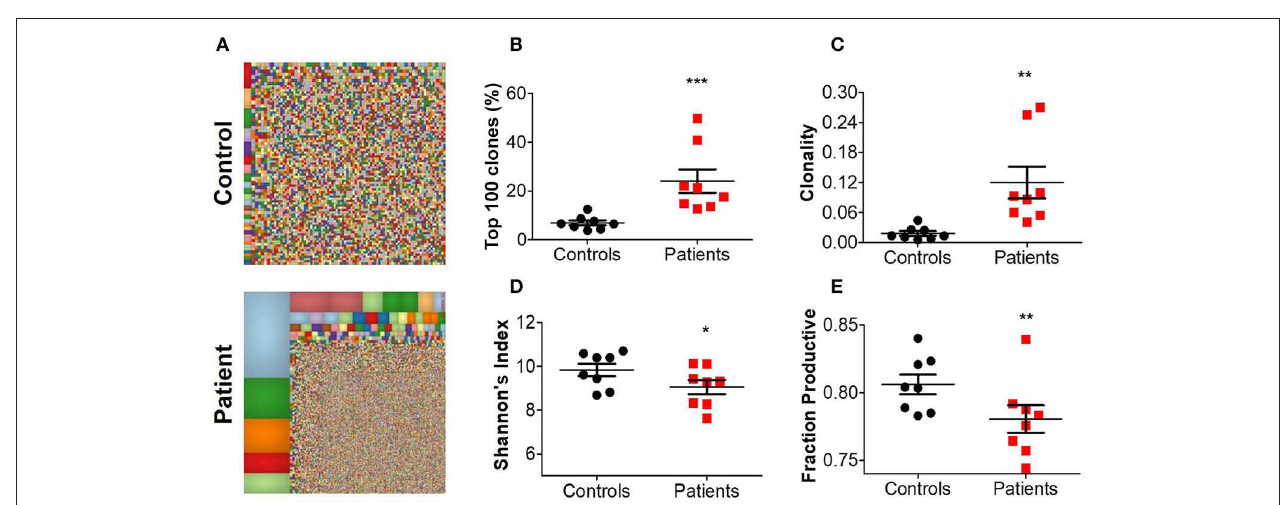
FIGURE 2 | Aberrant TCR repertoire features in blood from patients with IL10 signaling defects. (A) Representative Treemaps of entire TCR repertoire in a control (C1) and an IL10R-deficient patient (P2). (B) Cumulative percentage of the 100 most abundant clones from the total repertoire, (C) calculated clonality, (D) Shannon’s diversity index, and (E) fraction productiveness in control and patient groups. Bars represent mean ± SEM.